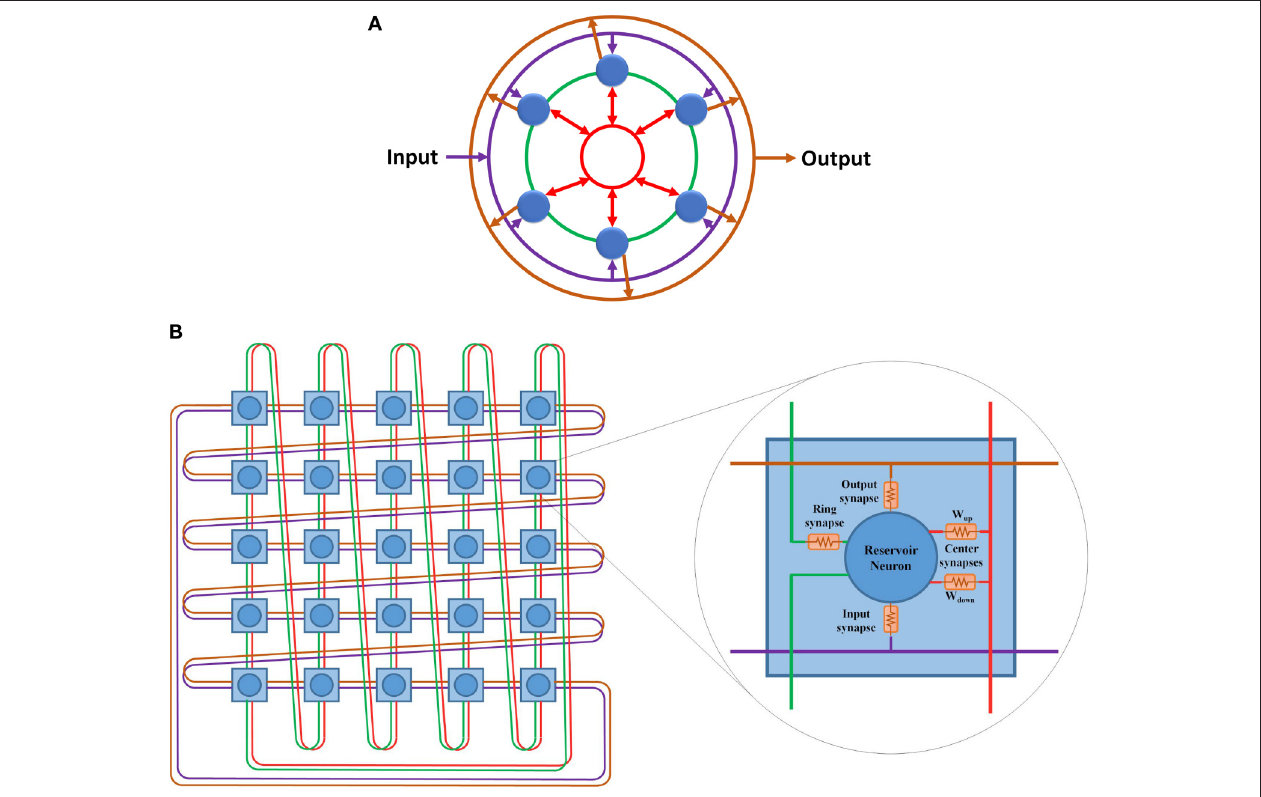
FIGURE 3 | (A) Hybrid topology implemented as four rings. The rings are color coded based on Figure 2 . Purple ring is used for the connections between the input layer and the reservoir layer. Green ring is used for the ring topology connections. Red ring is used for the center neuron connections. Orange ring is used for the connections between the reservoir layer and the output layer. (B) 5 x 5 doubly twisted toroidal network used to implement a 25 neurons hybrid reservoir. Dual links are used in this toroidal architecture to implement the four ring connection patterns required for the hybrid reservoir topology. The internal structure of each node in utilized toroidal architecture is shown. Each node contains a reservoir neuron along with all associated synaptic links.